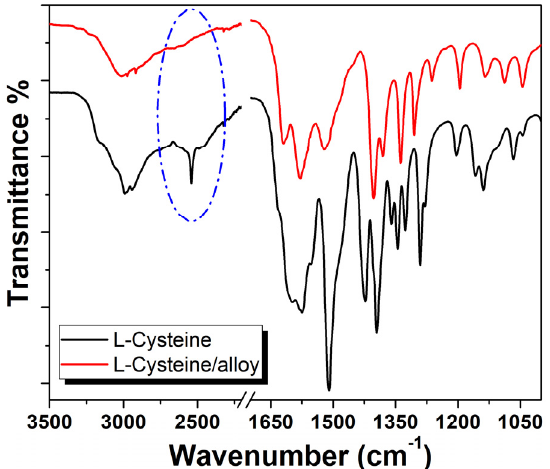
Figure 6. Comparison between the FTIR spectrum of cysteine deposited on the Cu-based alloy and the pure cysteine amino-acid, red and black line, respectively. Blue line show thiol vibration .